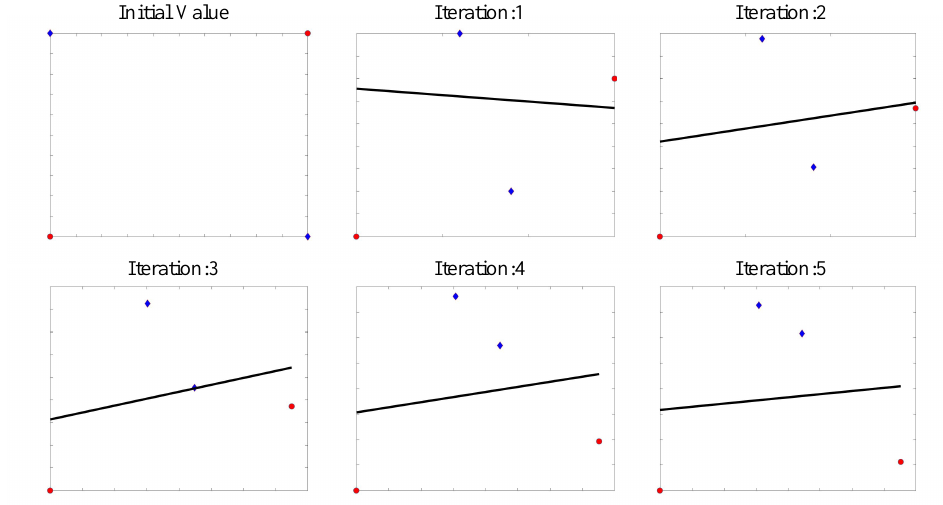
Figure 2. A toy experiment of using ADO for XOR